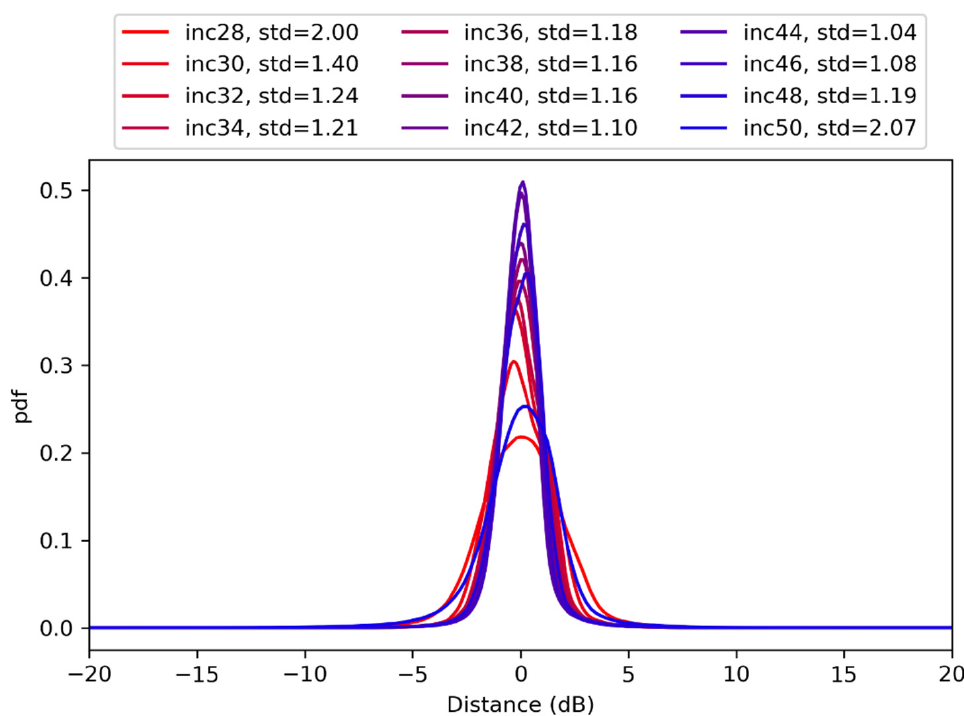
Figure 4. Gaussian distribution of the distance between sea-ice backscatter and the corresponding sea-ice GMF per incidence angle with standard deviation (red to blue indicates incidence angle from low, 28°, to high, 50°).